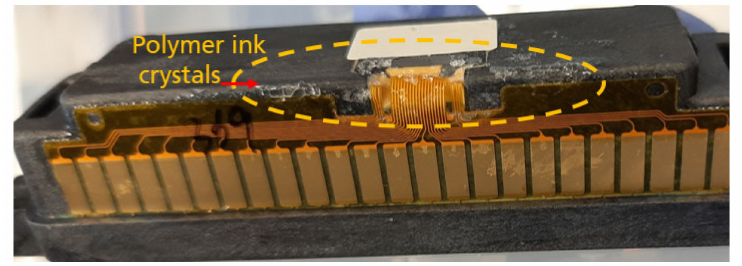
Figure 6. Strain-induced crystal formation for P-ink (2) around the printhead